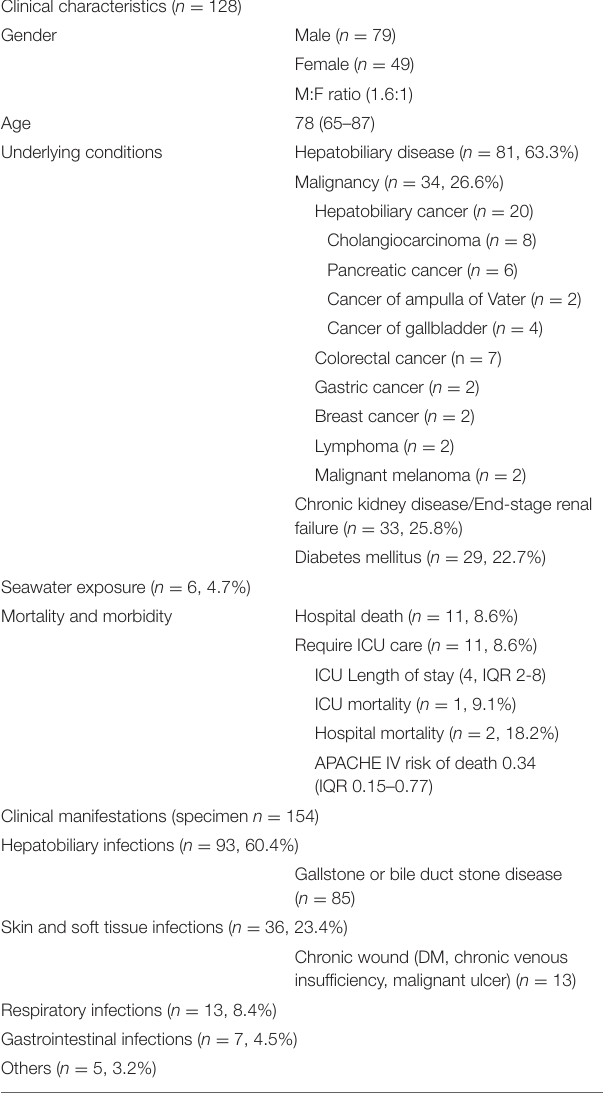
TABLE 1 | Clinical characteristics of Shewanella-associated sepsis. Clinical characteristics ( n = 128)